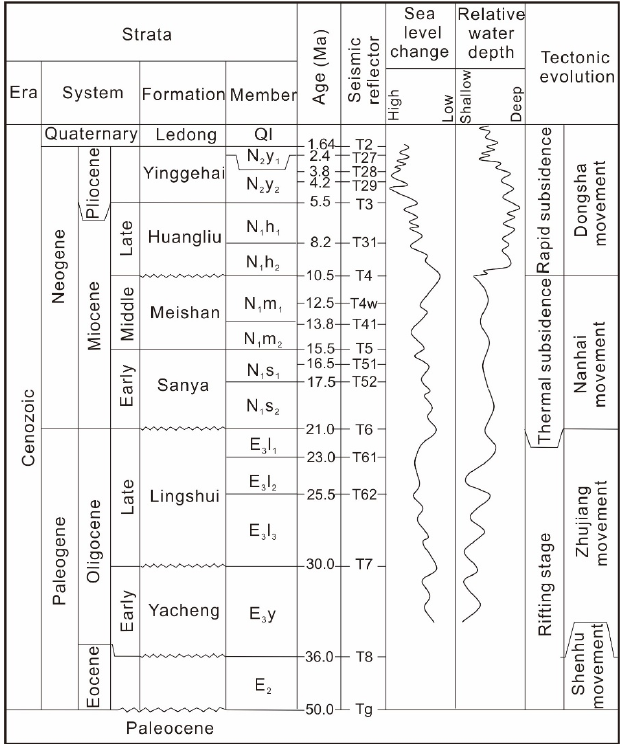
Figure 2. Generalized stratigraphic column of the Qiongdongnan Basin (modified from [28,29]).